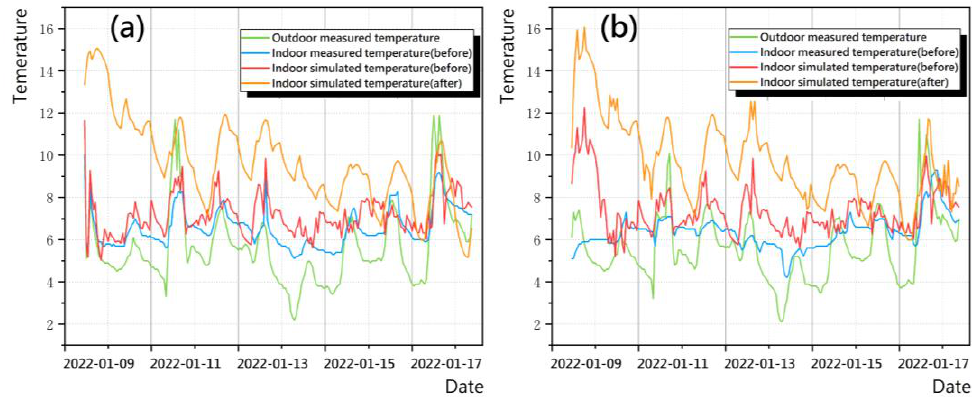
Figure 13. The comparison of thermal environment before and after improvement in the two types of dwelling in 10 days. ( a ) The comparison of “I-shaped” dwelling indoor thermal environment; ( b ) The comparison of “L-shaped” dwelling indoor thermal environment. Table 12. The energy consumption after